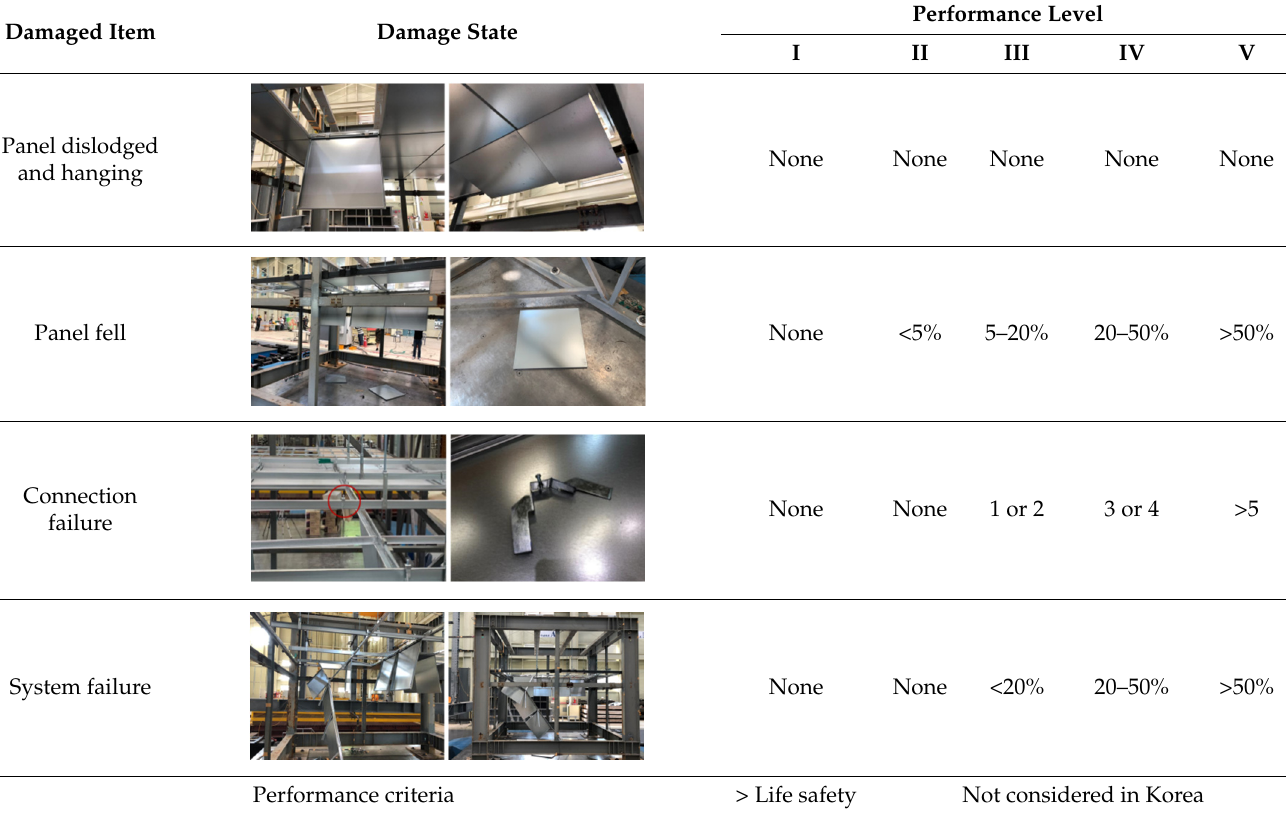
Table 4. Damage state and the performance level of the T-bar type steel panel ceiling.